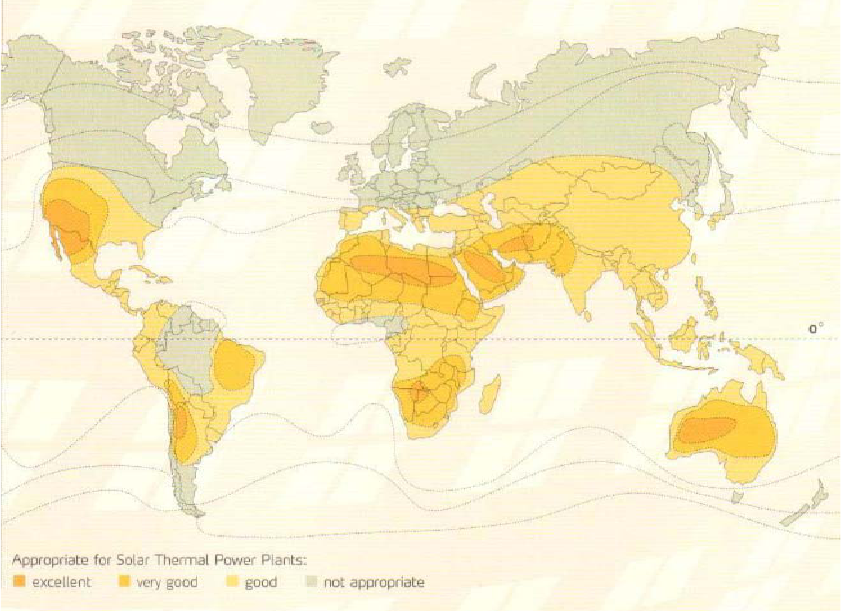
Figure 65. World areas with high potential for Concentrating Solar Power (© 2004 Rainer Aringhoff, reproduced with permission from